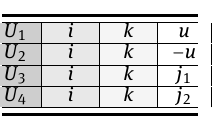
Table 7. Index distribution of the codewords of D ik ∪ E ik .